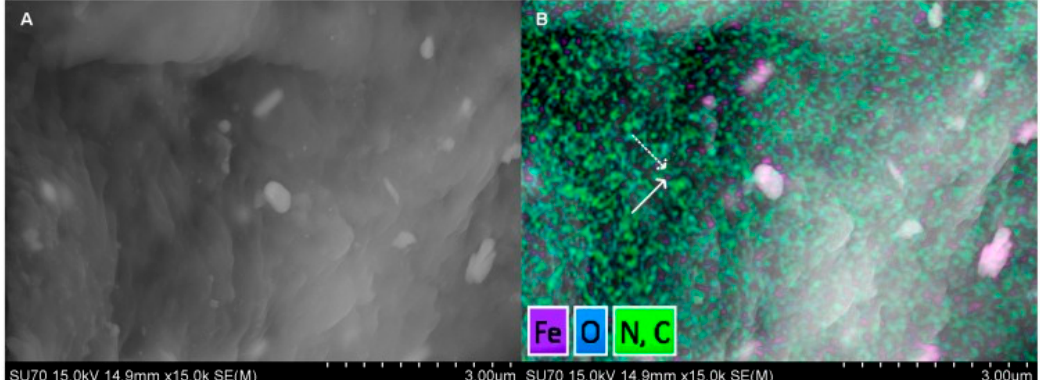
Figure 4. Molecular characterization of muJ591:MIRK from Bates et al. (2014); ( A ) a Scanning Electron Micrograph (SEM) image. ( B ) A superposition of the elements C, O, N and Fe (SEM mapping with Energy Dispersive X-ray (EDX)). Soild arrow shows the iron signal (MIRB nanoparticles) and the dashed arrow shows the antibody as organic matter signal. For Scanning Electron Micrograph (SEM) imaging, the sample must be completely dry. The result of this step is the formation of crystalline salts from the buffer (large white structures).